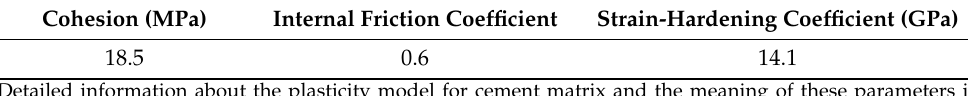
Table 2. Parameters of the plasticity model for cement